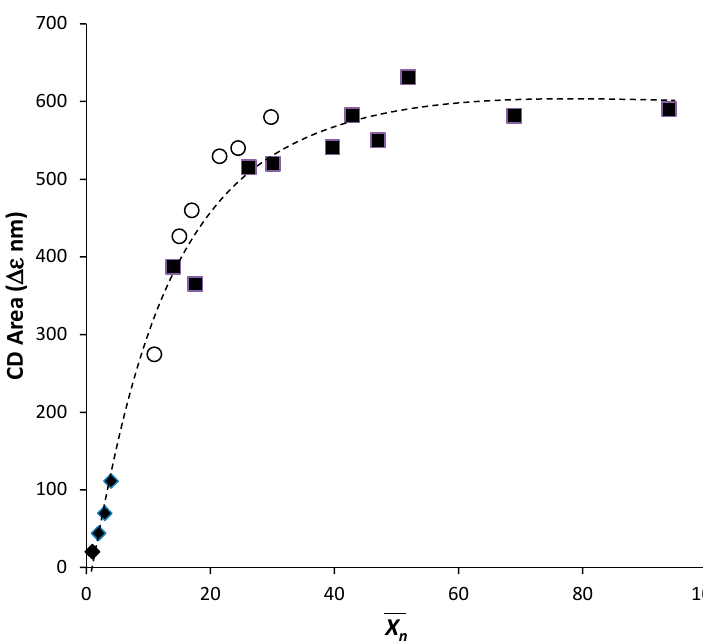
Figure 5. Evolution of the amplitude of the CD exciton couplet versus the average number polymerization degree relative to the oligomeric derivatives ( ♦ ) [50] and polymeric samples of poly[( S )-3-methacryloyloxy-1-(4-azobenzene)pyrrolidine] [poly[( S )- MAP ] obtained by different free and living radical polymerization methods ( ■ ) [50] ( ○ ) [49].